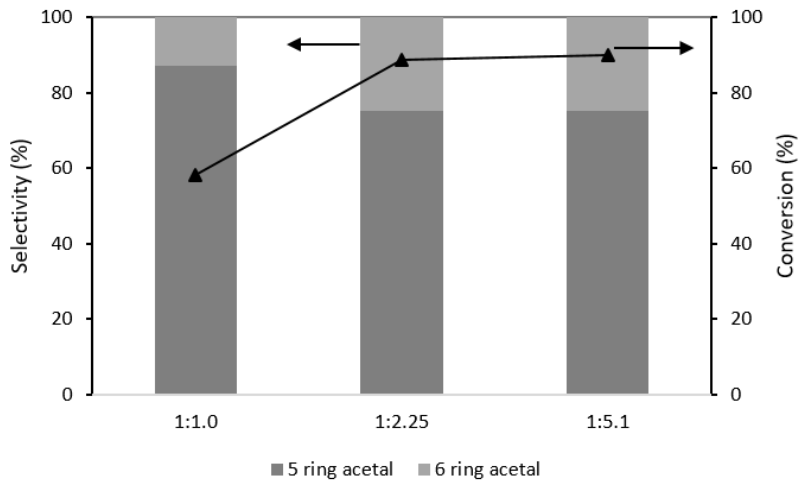
Figure 11. Acetalization of glycerol with citral over PW4-K-6. Effect of glycerol:citral molar ratio, after 5 h of reaction.